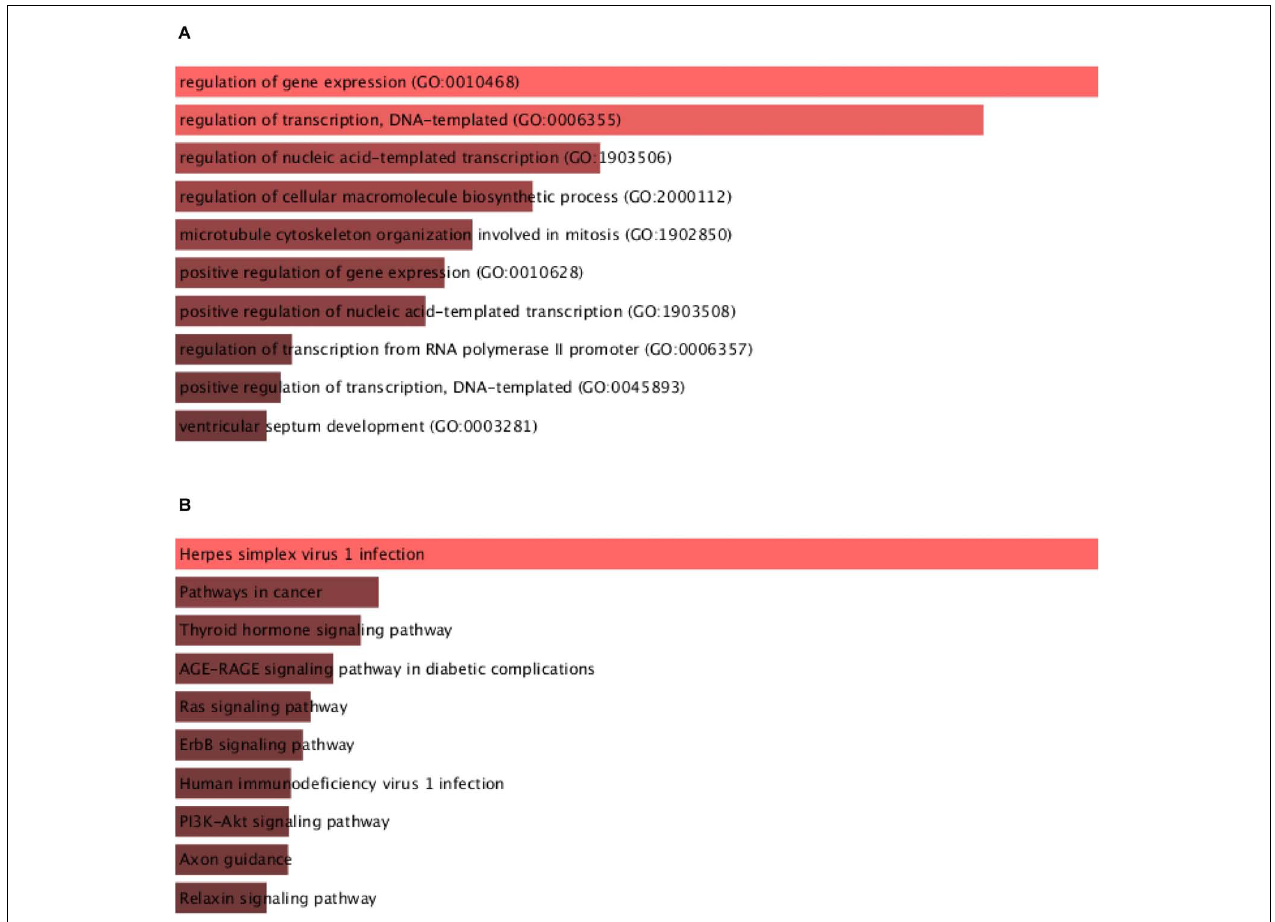
FIGURE 4 | Bioinformatics analysis of circHIPK3 in glioma. (A) GO analysis of circHIPK3 in gliomas showed that it was involved in the regulation of gene expression and transcription. (B) Analysis of the KEGG pathway of circHIPK3 showed that it is involved in regulating Thyroid hormone signaling, Ras pathway, and ErbB